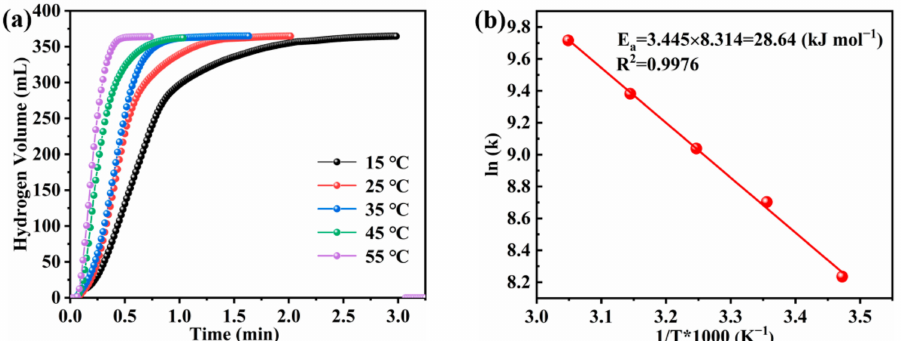
Figure 11. ( a ) Hydrogen generation kinetics curves and ( b ) Arrhenius plot obtained using 1.5 wt% NaBH 4 and 1.0 wt% NaOH solution and employing Co-B-P/75rGO as a catalyst at dif- ferent solution temperatures.